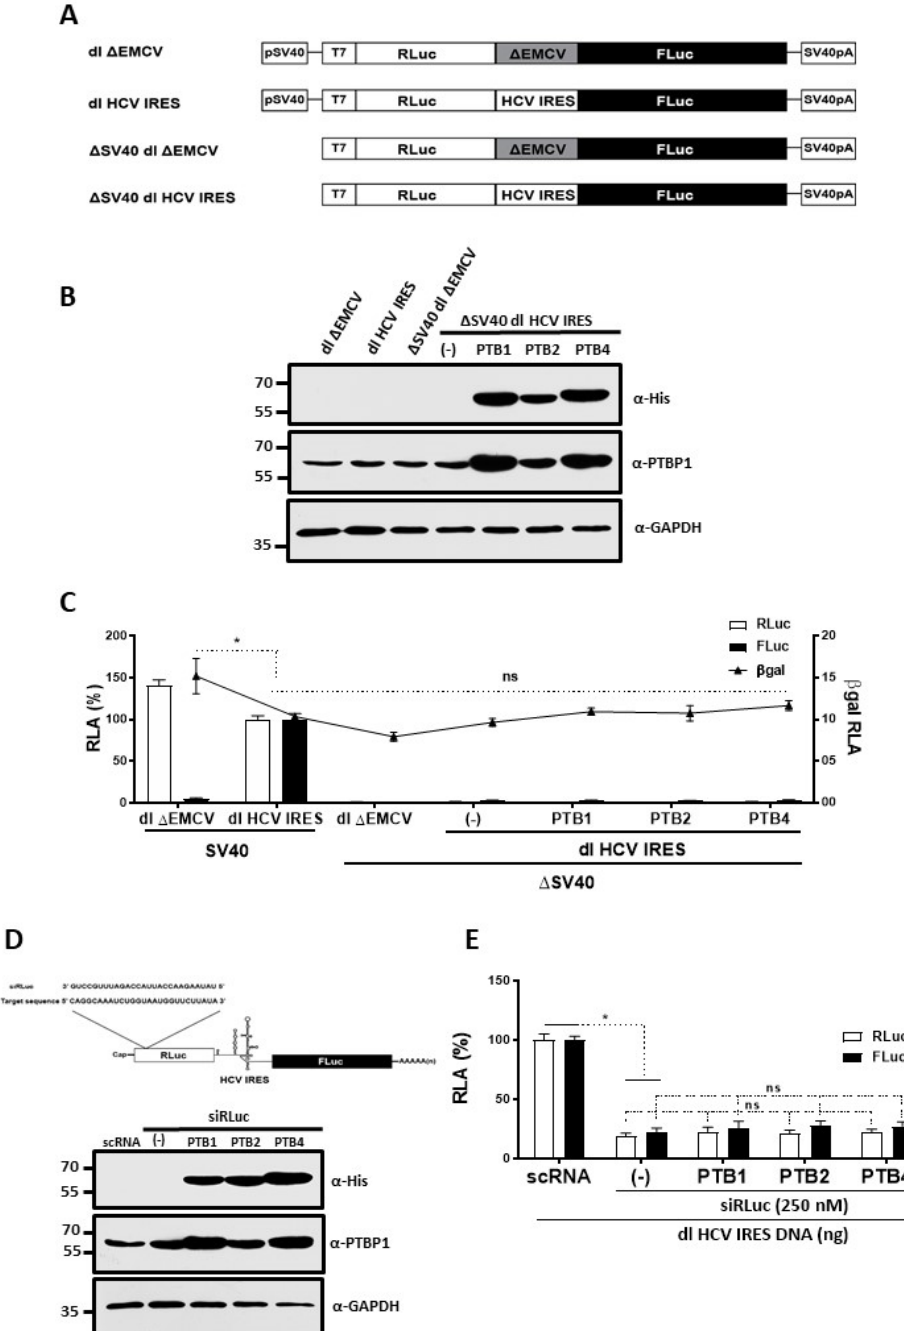
Figure 3. PTB isoforms do not induce alternative splicing nor cryptic promoter activity from the dl HCV IRES reporter. ( A ) Schematic representation of the Renilla luciferase (RLuc) and firefly luciferase (FLuc) bicistronic constructs. The SV40 and T7 promoters and the region corresponding to the defective encephalomyocarditis virus ( ∆ EMCV) IRES are highlighted. The SV40 promoter from the dl HCV IRES was removed to generate the equivalent promoterless ( ∆ SV40) vector. SV40pA represents the SV40 polyadenylation signal. ( B , C ) HuH-7 cells were transfected with 200 ng of the dl HCV IRES, dl ∆ EMCV, ∆ SV40 dl HCV IRES, or ∆ SV40 dl ∆ EMCV DNA, the pcDNA3.1-LacZ DNA (25 ng), and the pSP64-Poly(A) empty vector (-) or plasmids expressing the PTB isoforms (1 µ g). Total protein was extracted 24 h post-transfection. ( B ) Western blot detection of endogenous PTB ( α PTBP1), recombinant His-PTB1, His-PTB2, His-PTB4 ( α His), and GAPDH ( α GAPDH). ( C ) The RLuc and